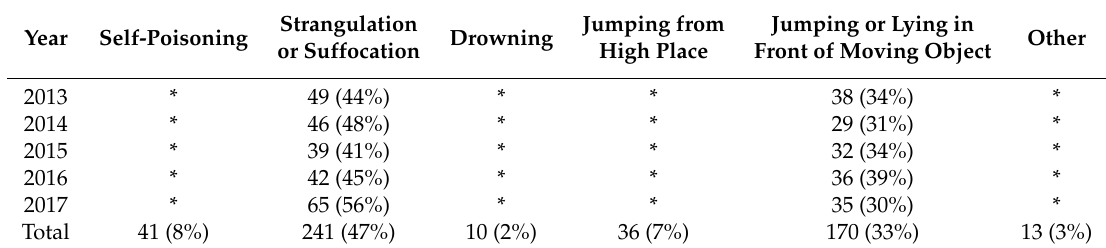
Table 9. Number of suicides among youths under 23 separated out by method of suicide (percentage of total in year in brackets).